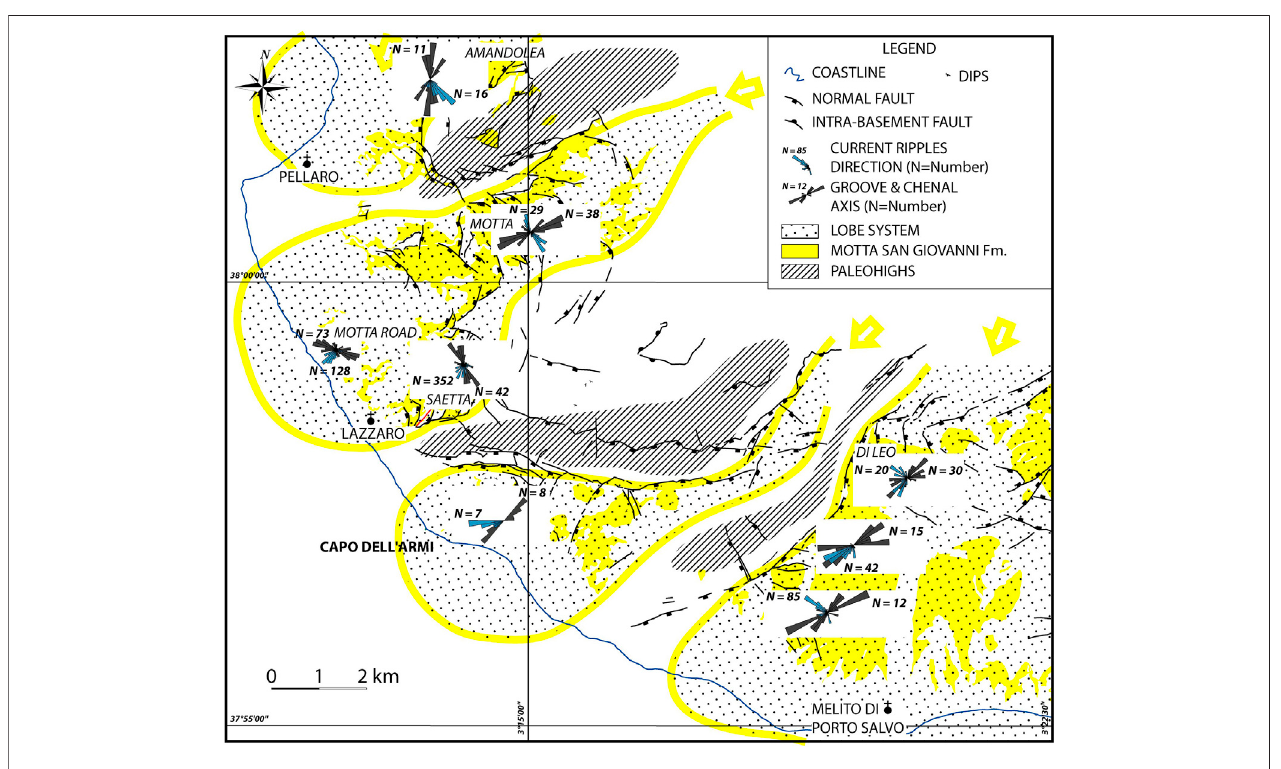
FIGURE 4 | Paleogeographic interpretation and lobe systems of the Motta San Giovanni Formation (Serravallian to Tortonian). Four systems are highlighted from NW to SE, separated by paleohighs corresponding to the crests of early Miocene tilted blocks. Yellow arrows illustrate to sediment supply entry points.